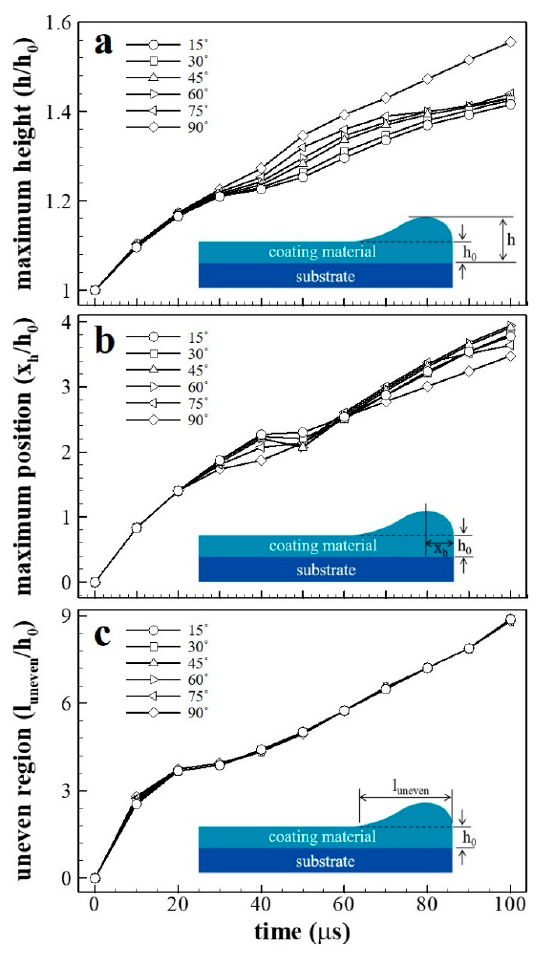
Figure 5. ( a ) Maximum height, ( b ) maximum position, and ( c ) uneven region analysis of the surface unevenness at the edge of the substrate with the same wetting conditions.